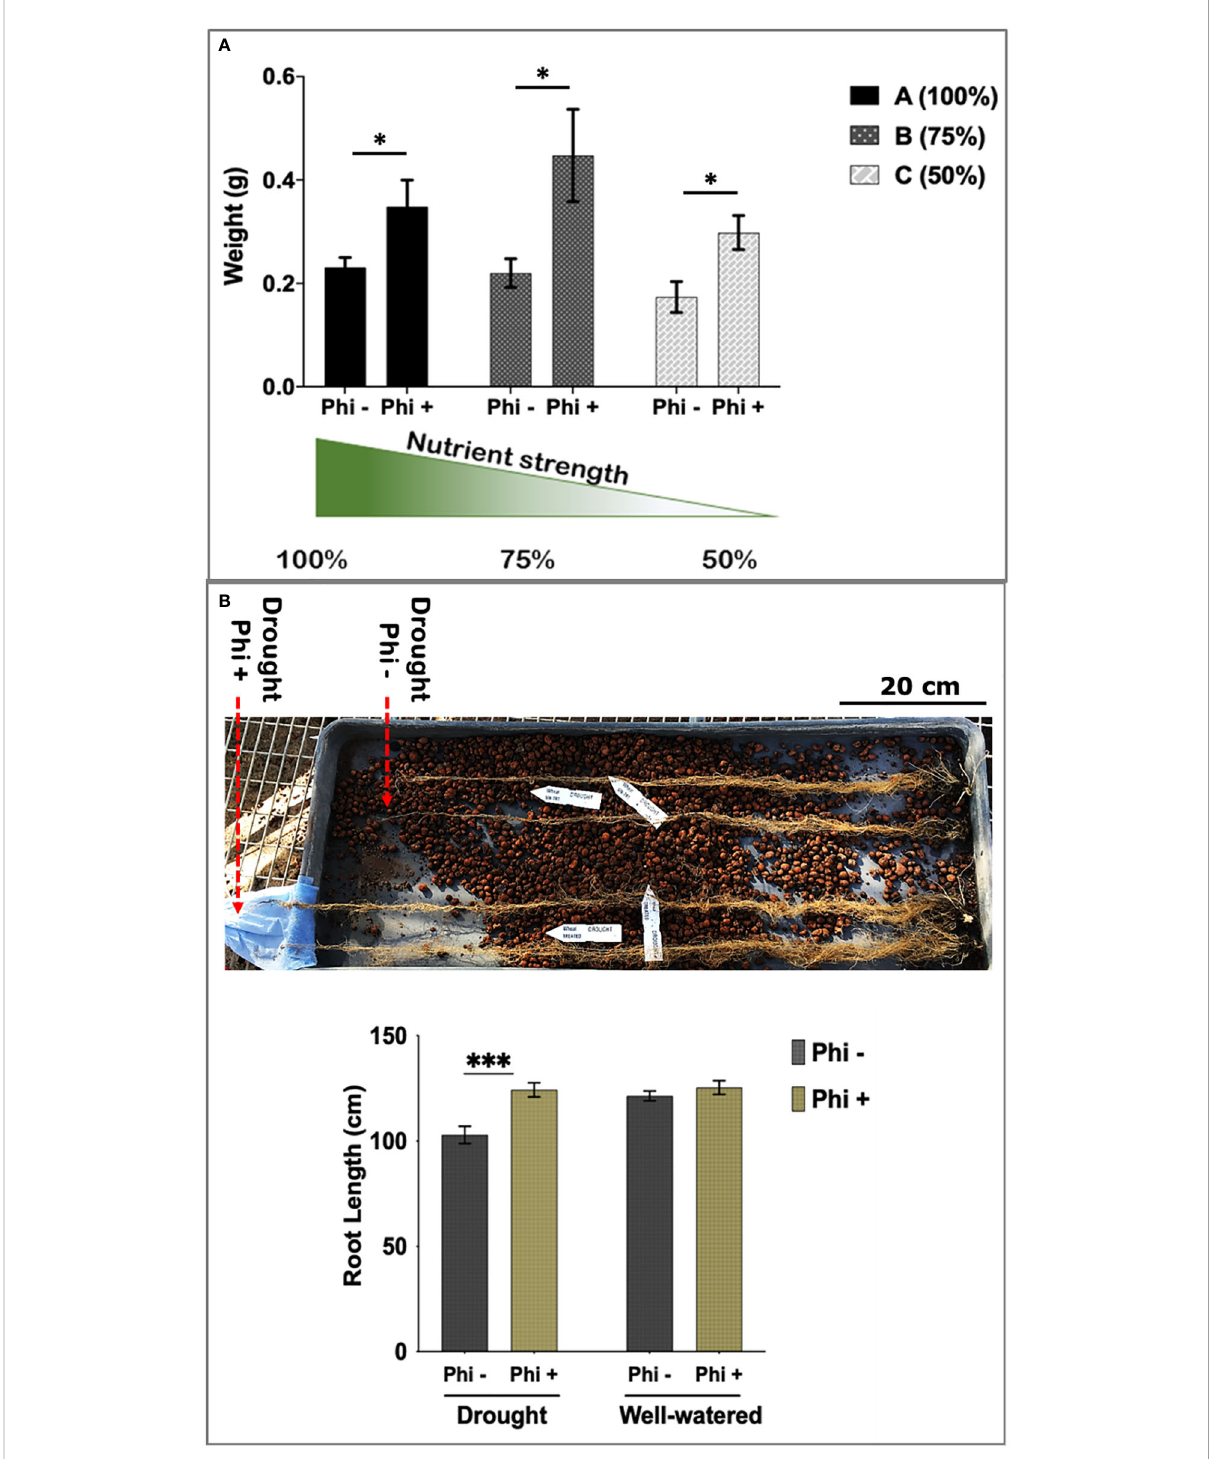
FIGURE 3 Phosphite treated plants show improved root development. (A) Root dry weight of Phosphite treated plants in pots under different nutrient strength of a commercial soluble fertilizer (NPK: 20-8-20) compared to untreated plants. *indicates signi fi cant difference (student ’ s t test P ≤ 0.05). (B) Deep columns were used to show an increase in maximum root length under mild drought compared to untreated plants. Arrowheads indicate end of root tips. Growth assessment 10-45 days after phosphite treatment. All values are means ± SE (n= 10-15); *indicates signi fi cant difference (*P ≤ 0.05 and ***P ≤ 0.001). Scale